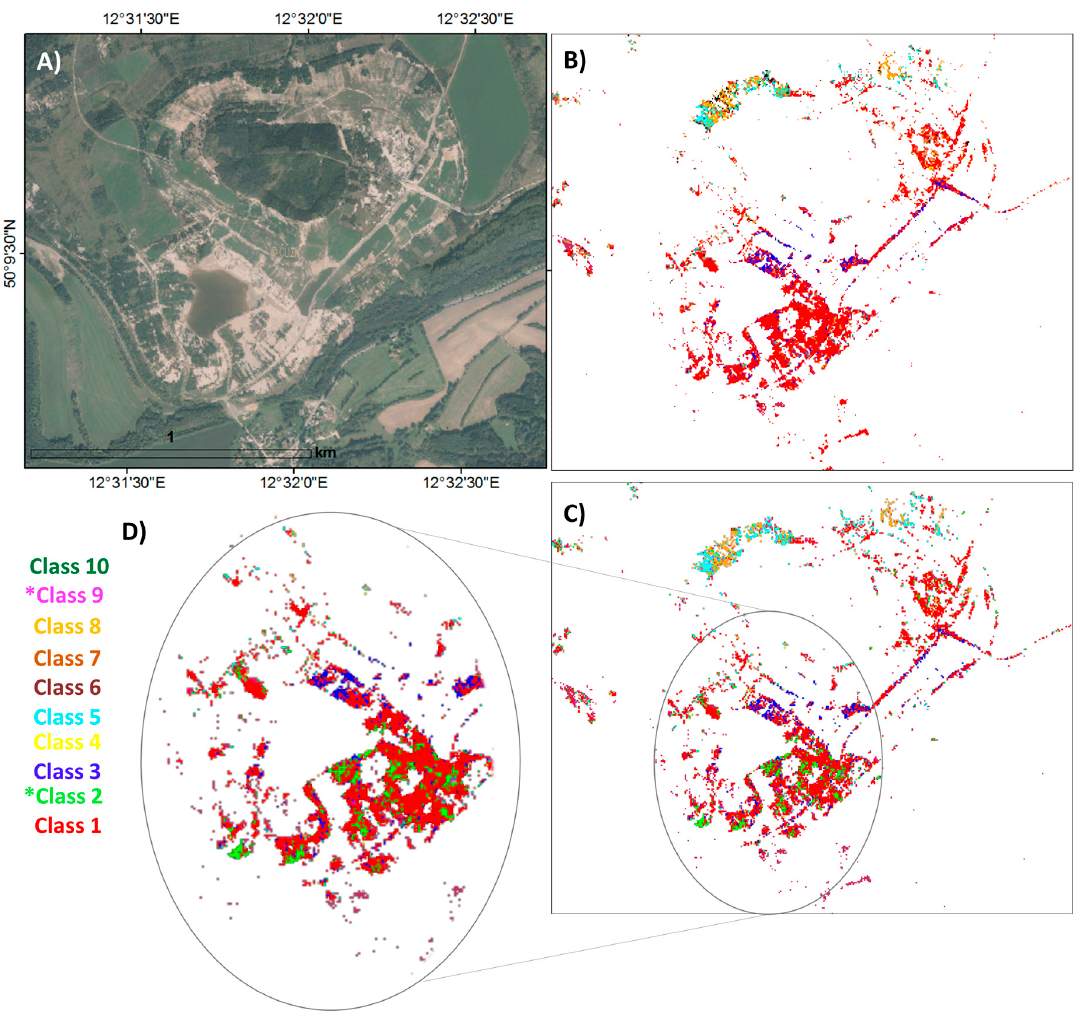
Figure 7. Lítov, mineral mapping: ( A ) orthophoto showing the Lítov dump; ( B ) classification using Scenario 1 (absorption feature parameters derived only from the HyMap data were used for the consequent mineral mapping), ( C ) classification using Scenario 2 (absorption feature parameters derived from both datasets, HyMap and AHS, were used for the consequent mineral mapping), ( D ) enlargement of the area of interest. The mapped classes correspond to the mineral classes in Table 1, *Class 2 and *Class 9: two additional classes mapped when using Scenario 2.